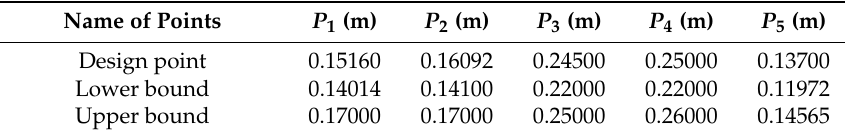
Table 1. Design points, lower and upper bound values of the optimization